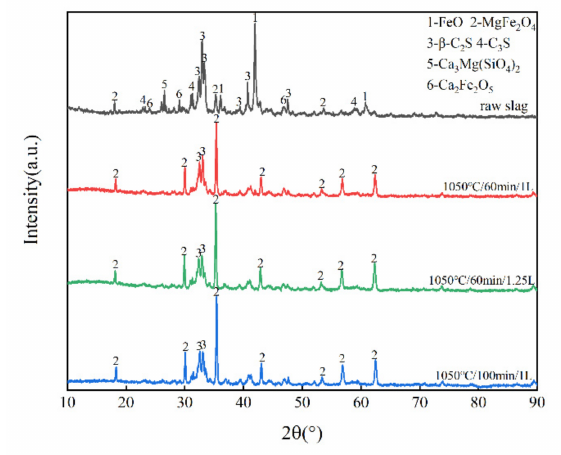
Figure 2. X-ray pattern of raw and oxidized slag under different conditions.